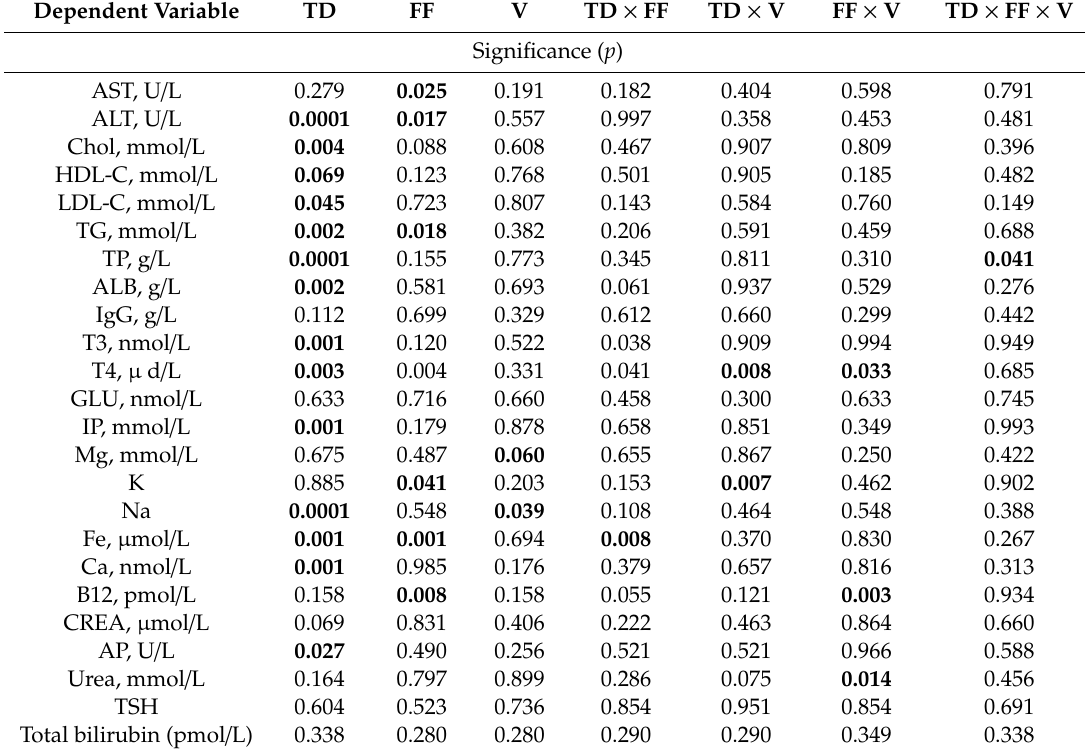
Table 4. Tests of between-subject e ff ects: influence of the analysed factors and their interaction on piglets’ blood